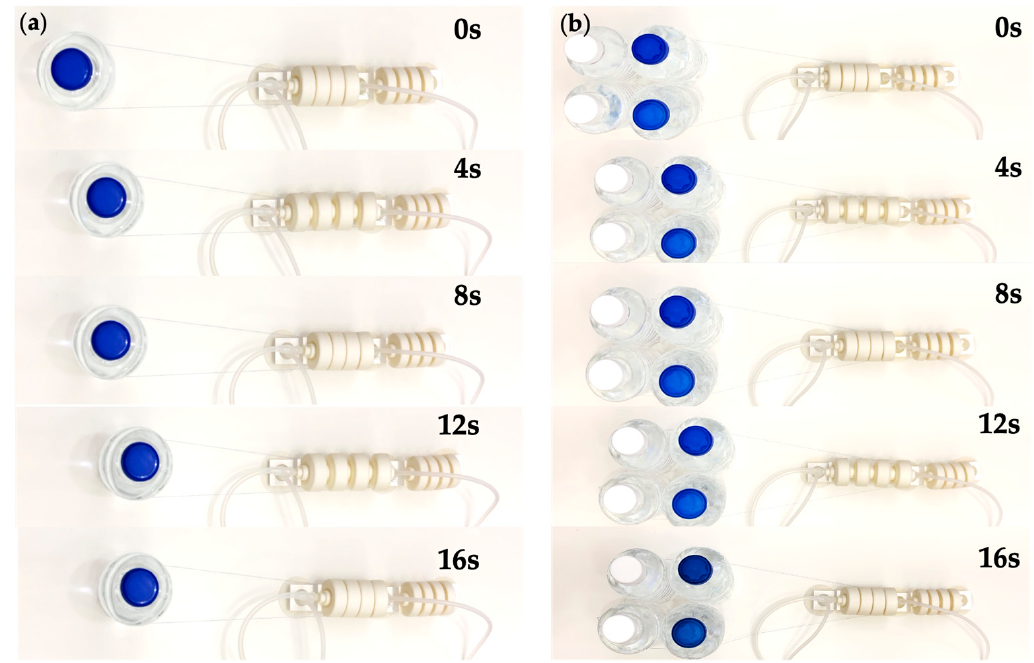
Figure 24. Load carrying capacity testing of the robot. ( a ) 500 g load. ( b ) 2000 g load.